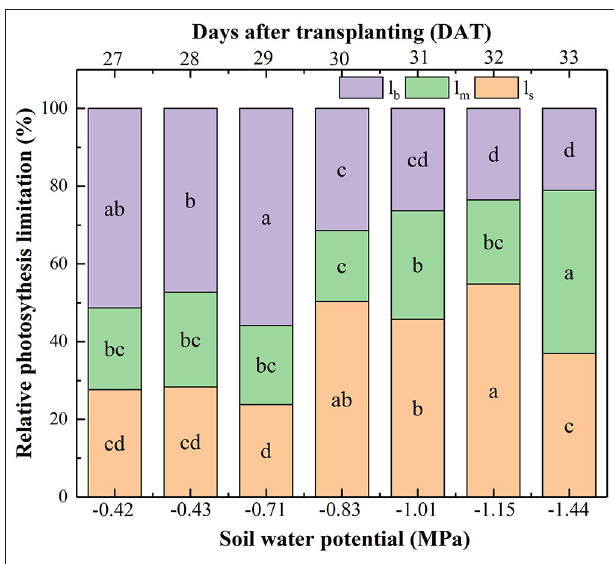
FIGURE 3 | Effect of soil water potential ( Ψ soil ) on the relative contribution of the photosynthesis capacity limiting factors: limitations of A n resulting from g s (l s ), g m (l m ), and biochemical photosynthetic capacity (l b ) after transplanting. Data were means. Different letters indicated statistically significant difference between well-watered (CK) and drought plants at P < 0.05